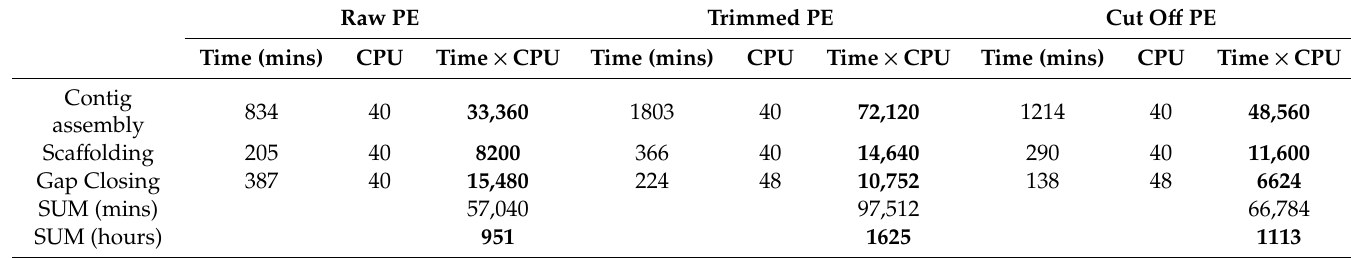
Table 4. Computational times for genome assembly based on three datasets using DISCOVARdenovo + SOAPdenovo2. The computational times for three genome assembly procedures, contig assembly, sca ff olding, and gap closing, were estimated,